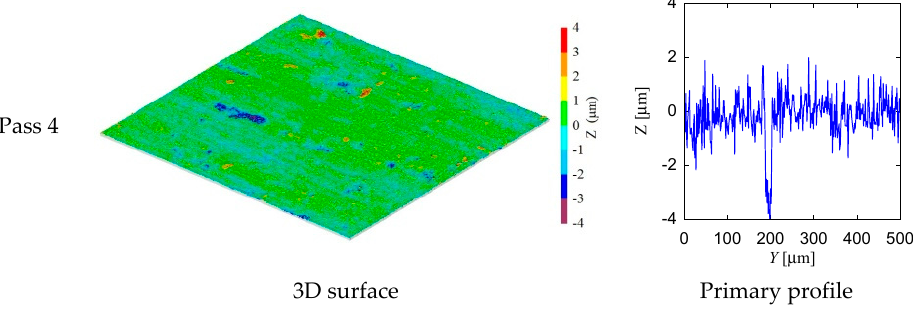
Figure 12. Surface topography of ground surface for feed rate V w = 100 mm/s. Table 1. Experimental Conditions.